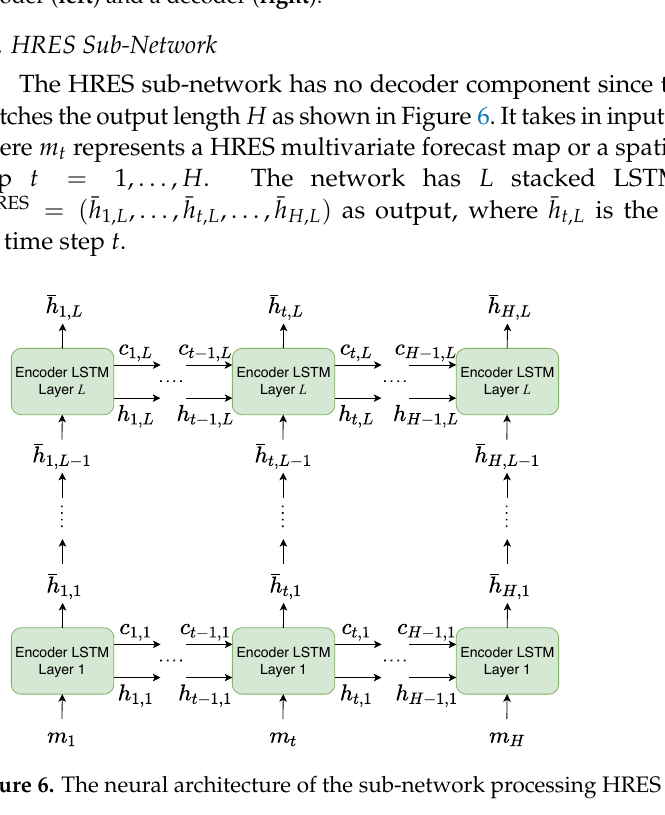
(backward) and future (forward) time steps. In fact, the outputs of two separate networks, one processing the original input sequences and one the input sequences in reversed order, are